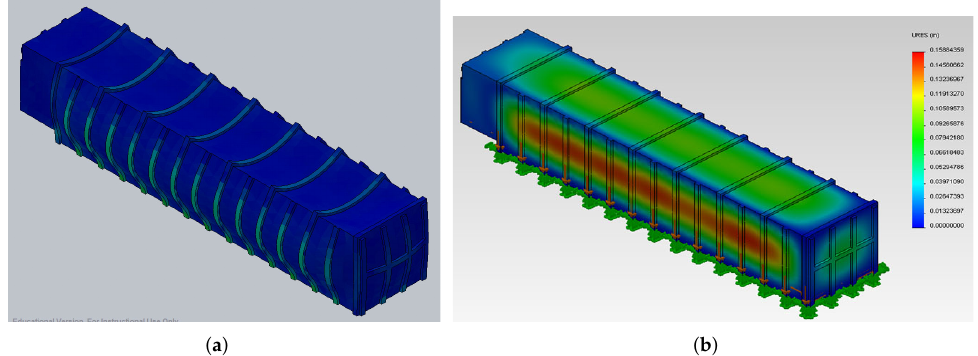
Figure 16. Solidworks simulation of the full-fledged three-dimensional solid model with end reinforcements.